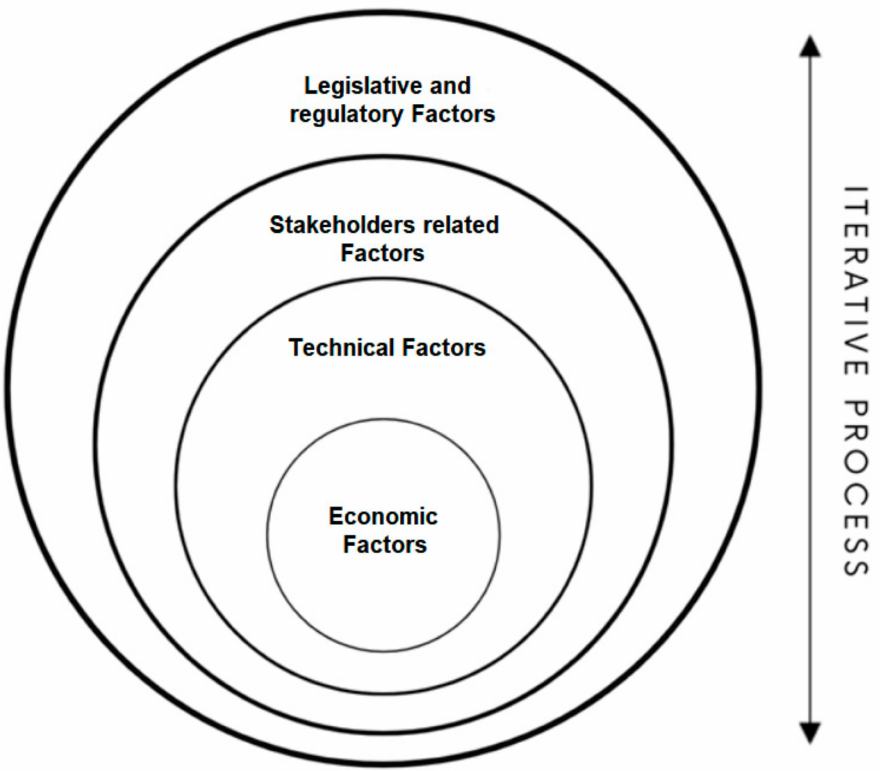
Figure 5. The relations among key scalability